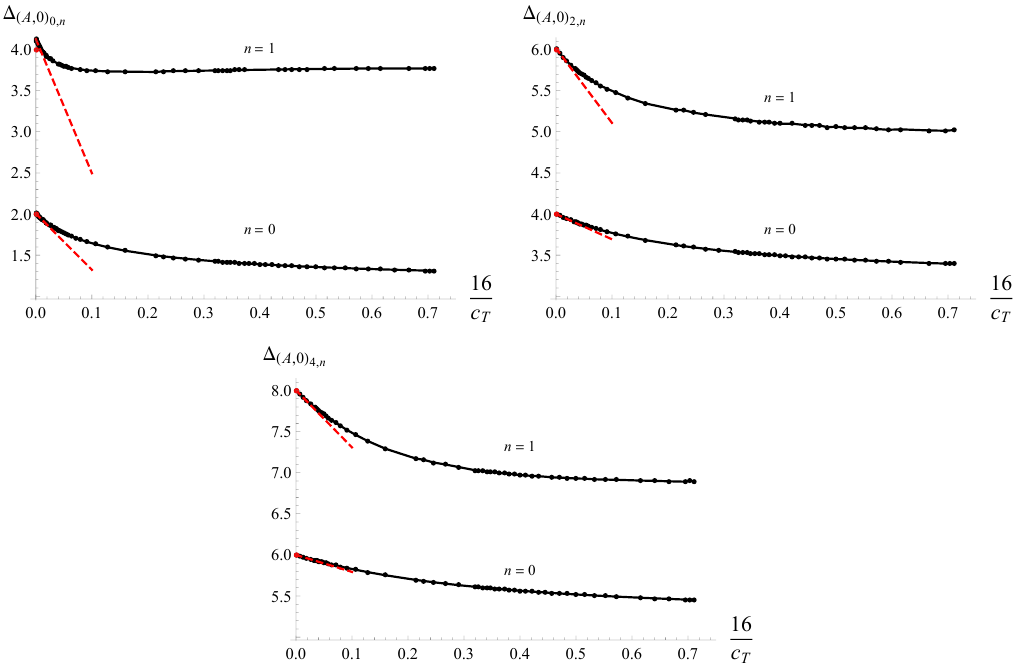
Figure 3 . The scaling dimensions (cid:1) for the two lowest n = 0 ; 1 long operators with spins ( A; 0) j;n j = 0 ; 2 ; 4 in terms of the stress-tensor coe(cid:14)cient c T , where the plot ranges from the generalized free (cid:12)eld theory limit c T ! 1 to the numerical point 16 (cid:25) : 71 where (cid:21) 2 = 0. The red dots denote ( B; 2) c T the known values (cid:1) ( n ) ; GFFT = j + 2 + 2 n for the generalized free (cid:12)eld theory, while the red dotted j lines show the linear (cid:12)t for large c T given in (5.3). These bounds were computed with (cid:3) =